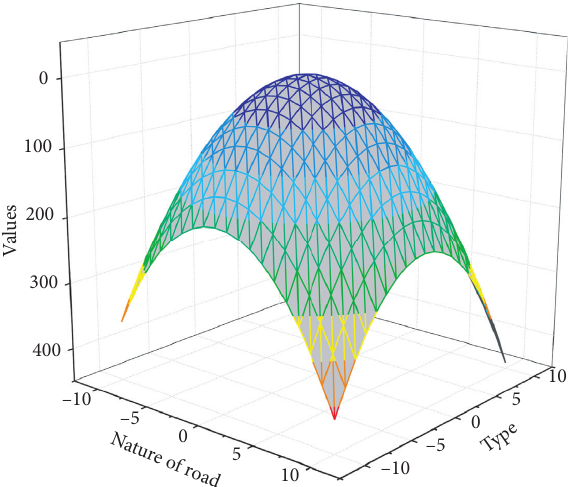
Figure 3: Schematic diagram of the calculation of symmetry salient features based on a contour